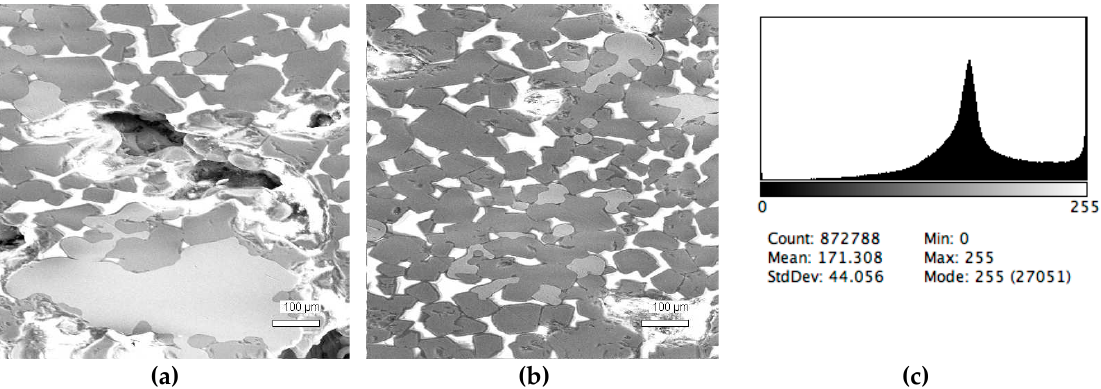
Figure 4. Typical back scattered electron images ( a , b ) of microstructures and contrast histogram ( c ) of the Sample #4 grind; SEM.